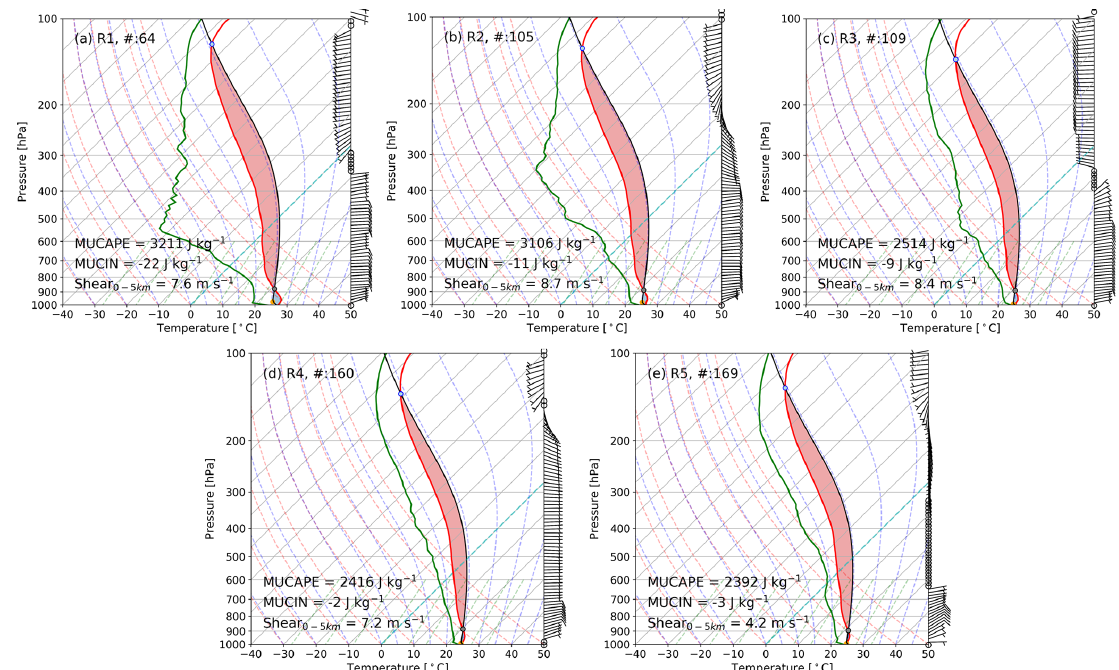
Figure 3. Composite 12:00UTC radiosondes for each regime. MUCAPE, MUCIN, and wind shear (surface to 5km) parameters report regime median